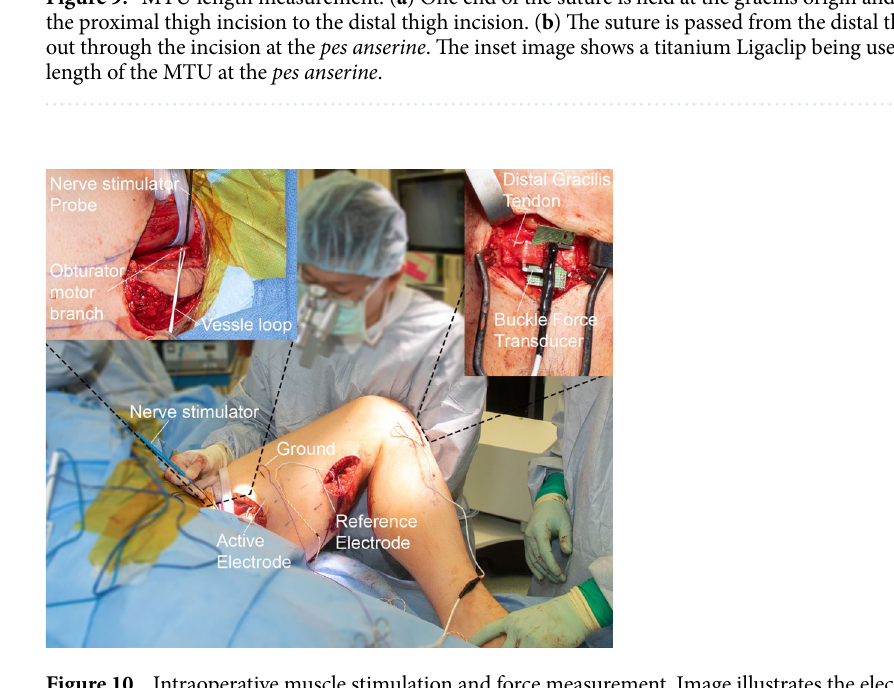
Figure 10. Intraoperative muscle stimulation and force measurement. Image illustrates the electrode placement required when stimulating the muscle. Left inset image shows the obturator nerve on hook of the nerve stimulator. Right inset image shows the distal tendon woven through the BFT arms. After the BFT is mounted, the incision is temporarily closed with surgical staples and the trailing wire is secured along the